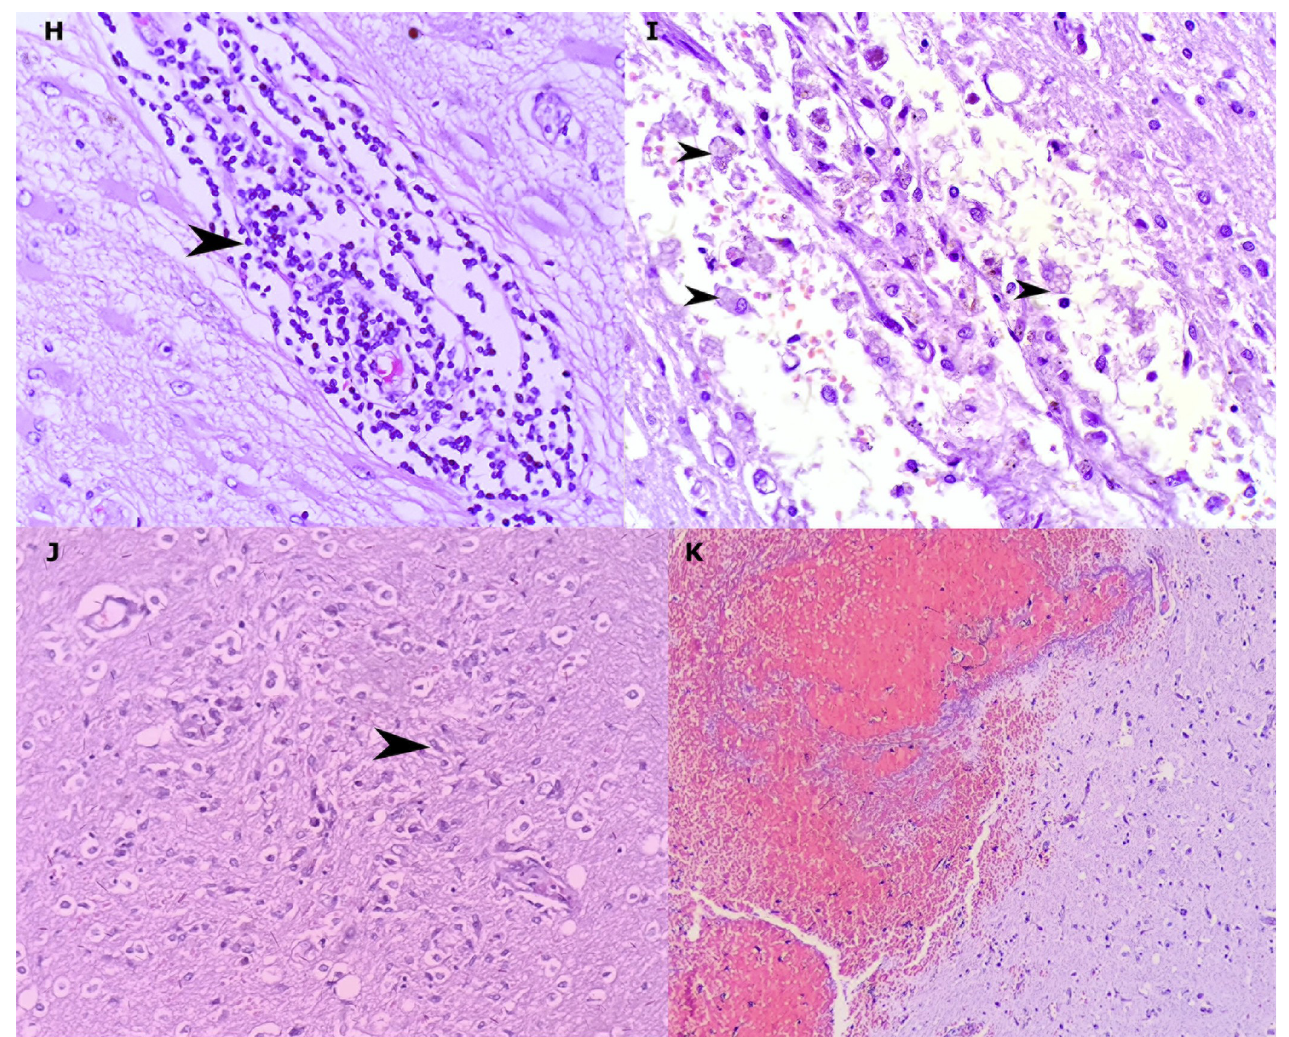
Fig 4. Inflammatory cells and reaction processes in the examined brains. Lymphocytes (arrowhead) forming bulky perivascular cuffing (H). Macrophages (arrowhead), red cell diapedesis and edema around blood vessels (I). Microglial nodule (microglia cell, arrowhead) (J). Occurrence of intraparenchymal hemorrhagic phenomenon without association with inflammatory process (K). (hematoxylin and eosin. H: 400x, I: 200x, K: